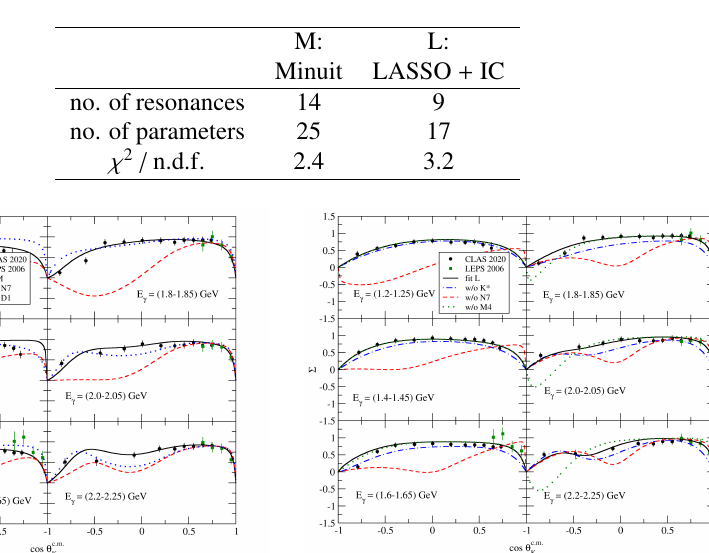
Figure 1. The Akaike (blue), a modified version known as ‘corrected Akaike’ (orange), and Bayesian (green) information criteria for various values of the regularization parameter λ . Please note the loga- rithmic scale of the vertical axis. (Taken from [5]). Table 1. Summary of the features of the two fits.